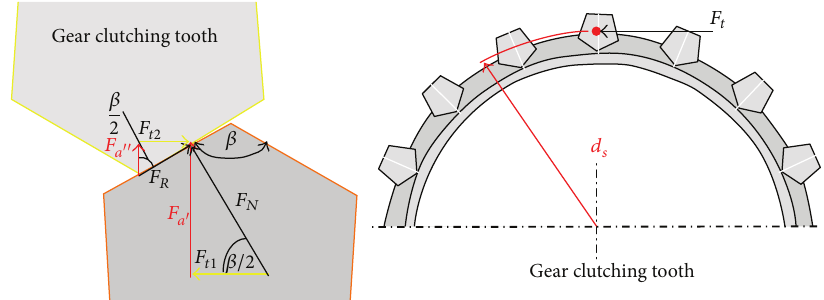
Figure 7: The acting forces applied on the tooth of shift sleeve and those on the shift gear.